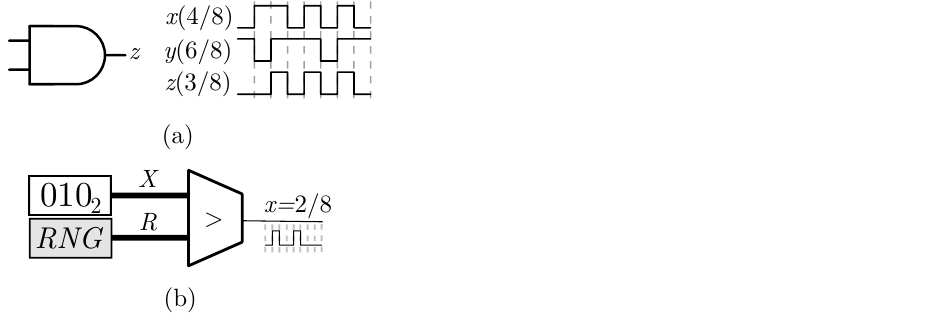
Figure 1. ( a ) Stochastic multiplication using an AND gate. ( b ) Stochastic number generator for an 8 BS